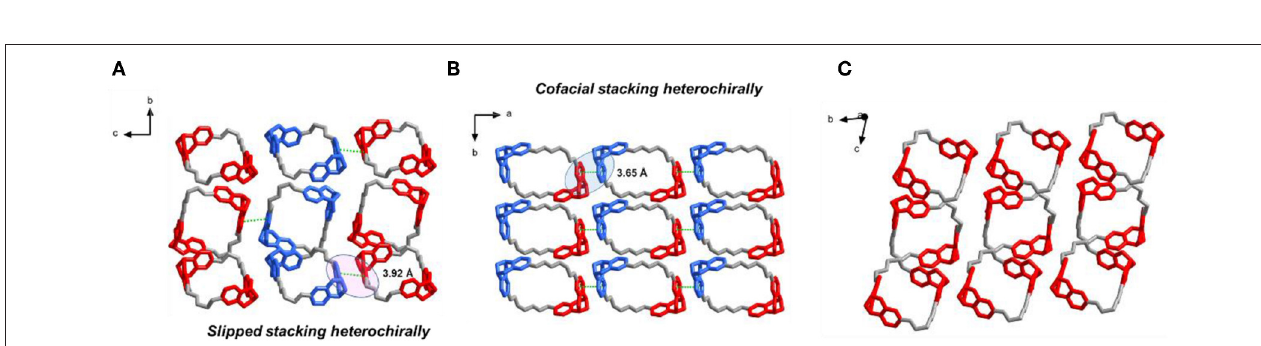
FIGURE 3 | Solid-state (super)structures of R 2 N S 2 N -T1 , rac -T1 , and S 4 N -T1 obtained from single-crystal X-ray crystallography. (A) Slipped π - π stacking between R 4 N -T1 and S 4 N -T1 molecules observed in rac -T1 crystal packing ( left ). (B) Cofacial π - π stacking between two R 2 N S 2 N -T1 molecules observed in crystal packing ( middle ). (C) Solid-state (super)structures of S 4 N -T1 molecules observed in crystal packing ( right ). TB units with S N S N are depicted in red, while TB units with R N R N are shown in